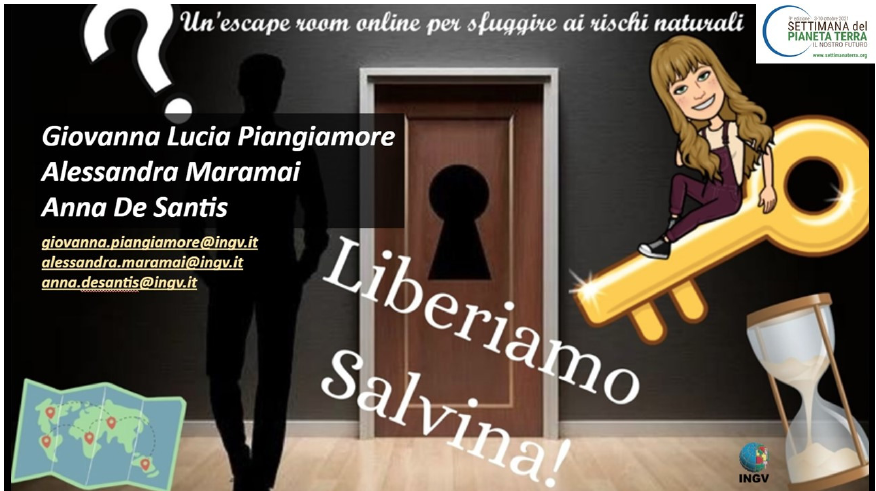
Figure 4. Flyer of the Let’s free Salvina! , an Escape Room to run away from natural risks, played online at the 9th Planet Earth Week 2021 .